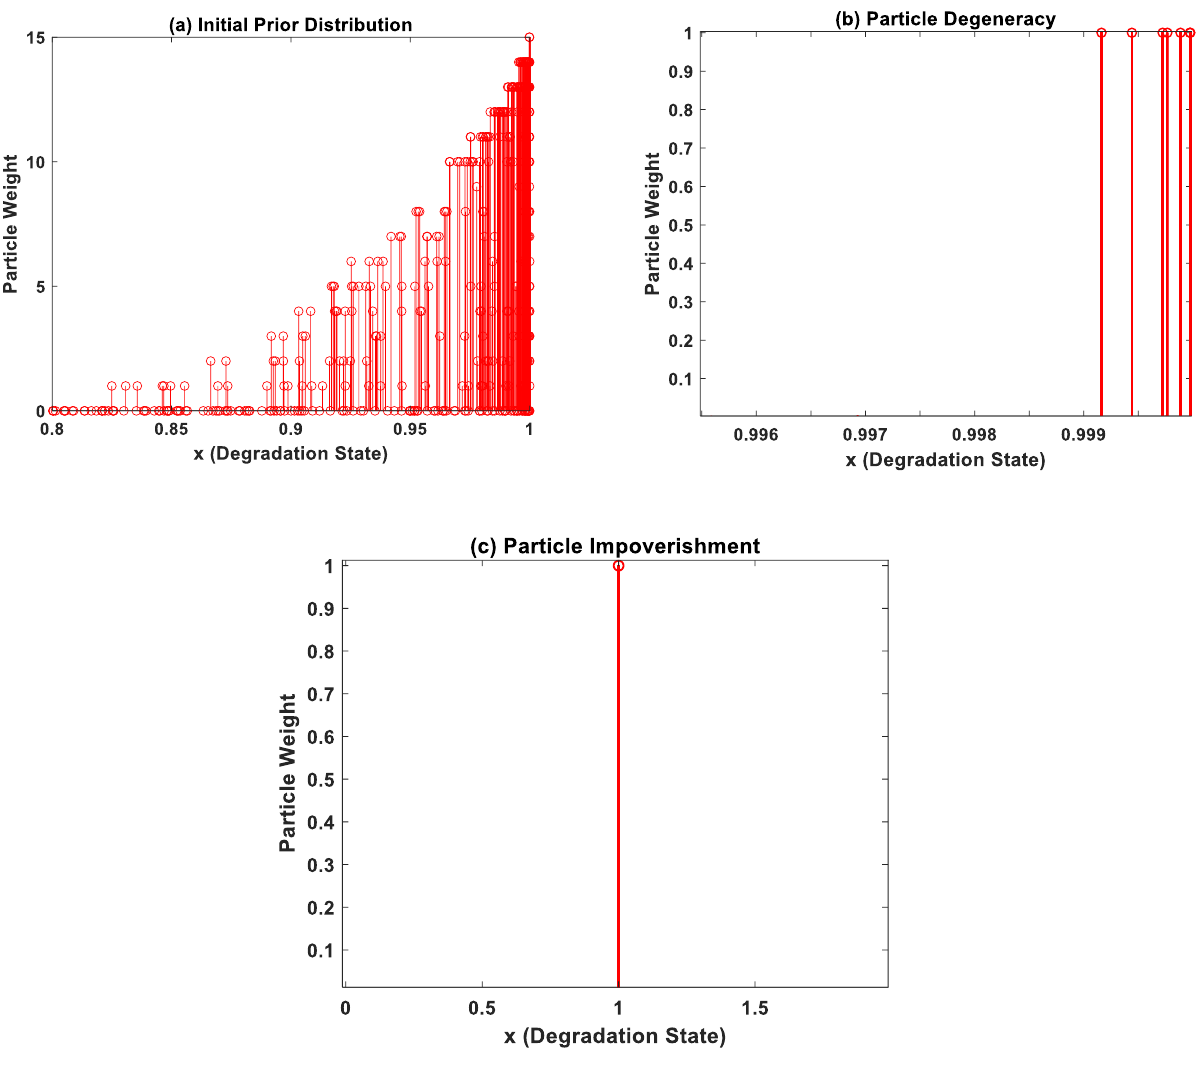
Figure 3. The particle weight distributions obtained while executing the PF algorithm: ( a ) Initial prior distribution; ( b ) weight distribution depicting particle degeneracy; and ( c ) weight distribution depicting particle impoverishment.